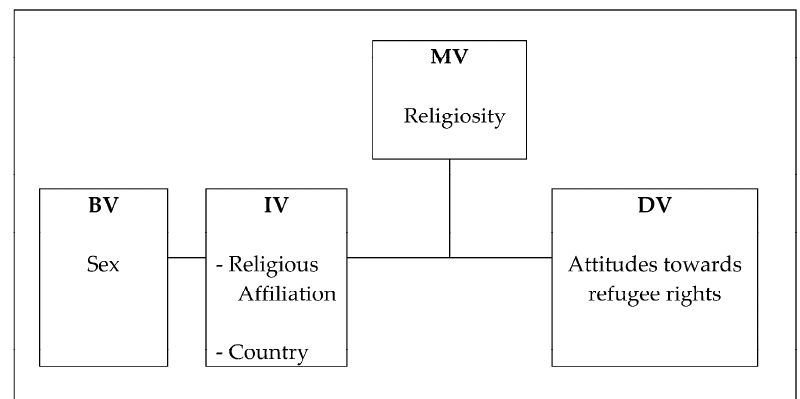
Figure 1. Conceptual model. MV: moderator variable, BV: background variable; IV: independent variable; DV: dependent variable.